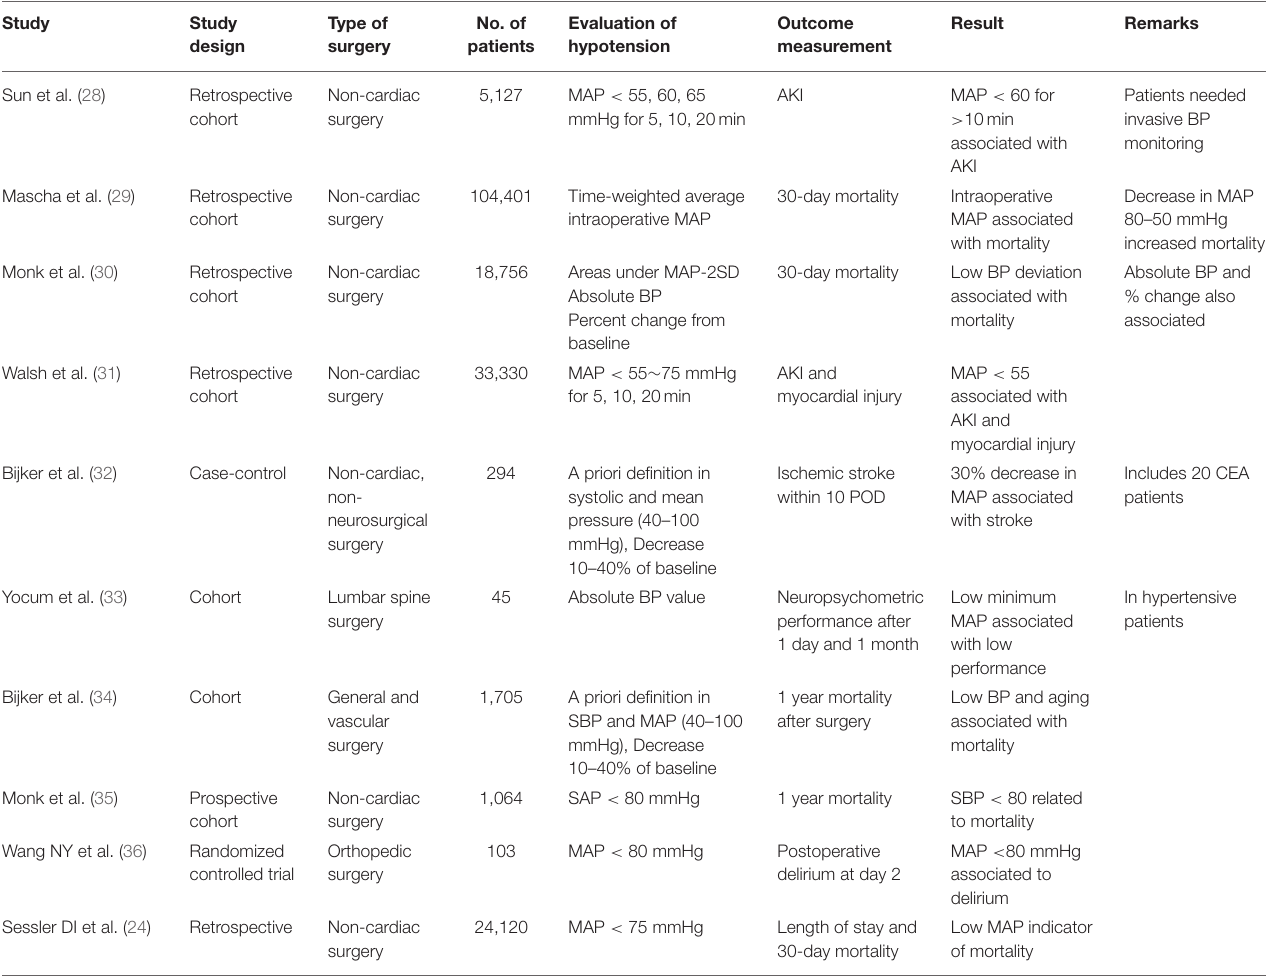
TABLE 3 | Intraoperative hypotension and adverse